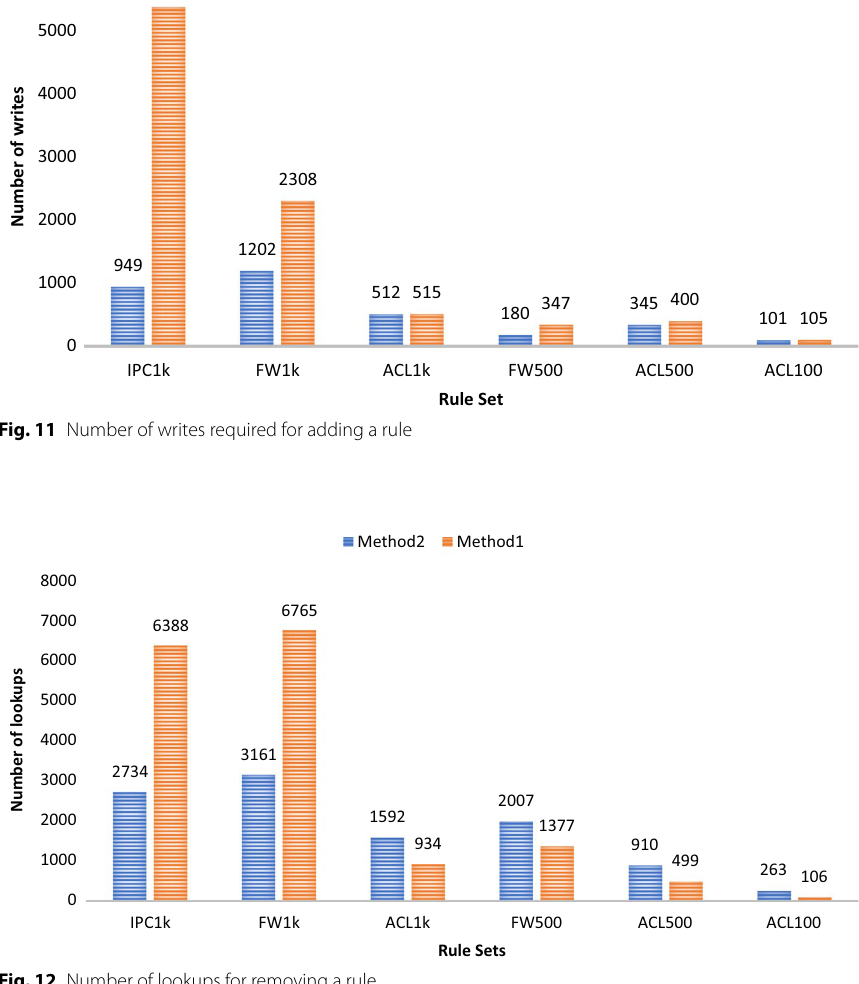
Fig. 12 Number of lookups for removing a